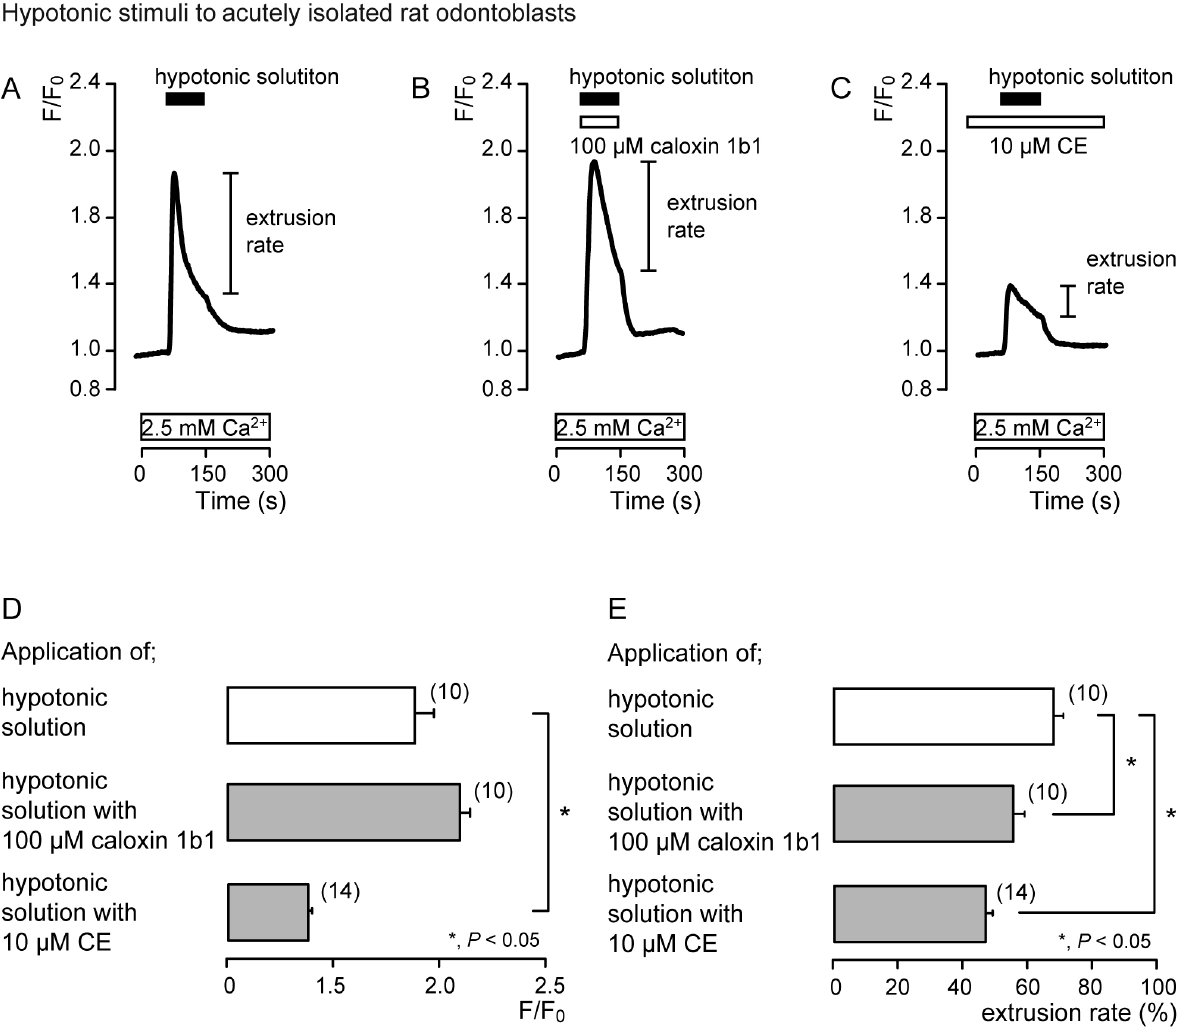
Figure 2. PMCA mediates Ca 2+ extrusion following hypotonic stimuli in acutely isolated rat odontoblasts. ( A – C ) Representative traces of intracellular free Ca 2+ concentration ([Ca 2+ ] i ) following hypotonic stimuli (black boxes at tops of graphs) in the absence of 100 µM caloxin 1b1 and 10 µM 5(6)-carboxyeosin (CE) ( A ), with 100 µM caloxin 1b1 (white box at the top) ( B ), or with 10 µM CE (white box at the top) ( C ), in the presence of extracellular Ca 2+ (white boxes at bottom in A to C). ( D ) Peak values of [Ca 2+ ] i during hypotonic stimuli without 100 µM caloxin 1b1 and 10 µM CE (open column; 1.88 ± 0.08 F/F 0 units), with 100 µM caloxin 1b1 (upper gray column; 2.08 ± 0.05 F/F 0 units), and with 10 µM CE (lower gray column; 1.37 ± 0.03 F/F 0 units). Each column denotes the mean ± SE from 10, 10, and 14 independent experiments, respectively. ( E ) Ca 2+ extrusion rates during hypotonic stimulation in the absence of 100 µM caloxin 1b1 and 10 µM CE (open column; 68.2 ± 2.8%), with 100 µM caloxin 1b1 (upper gray column; 55.8 ± 3.2%), and with 10 µM CE (lower gray column; 46.3 ± 2.4%). Each column denotes the mean ± SE from 10, 10, and 14 independent experiments, respectively. Statistically significant differences (in ( D , E )) between columns (shown by solid lines) are indicated by asterisks. * P < 0.05.